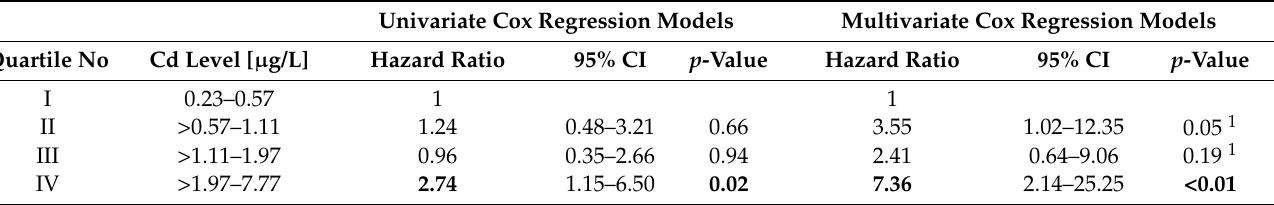
Table S7. The data and results for uni- and multi-variate analysis for the other clinical stages of lung cancer and heavy metals are available upon request. Table 3. Hazard ratios and 95% confidence intervals on survival from lung cancer depending on cadmium levels for patients with stage IA lung